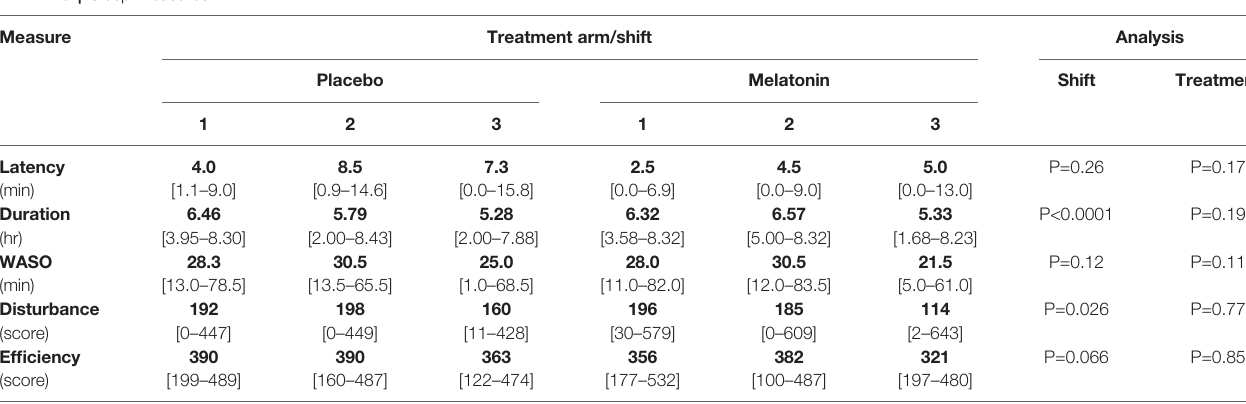
TABLE 3 | Sleep measures.